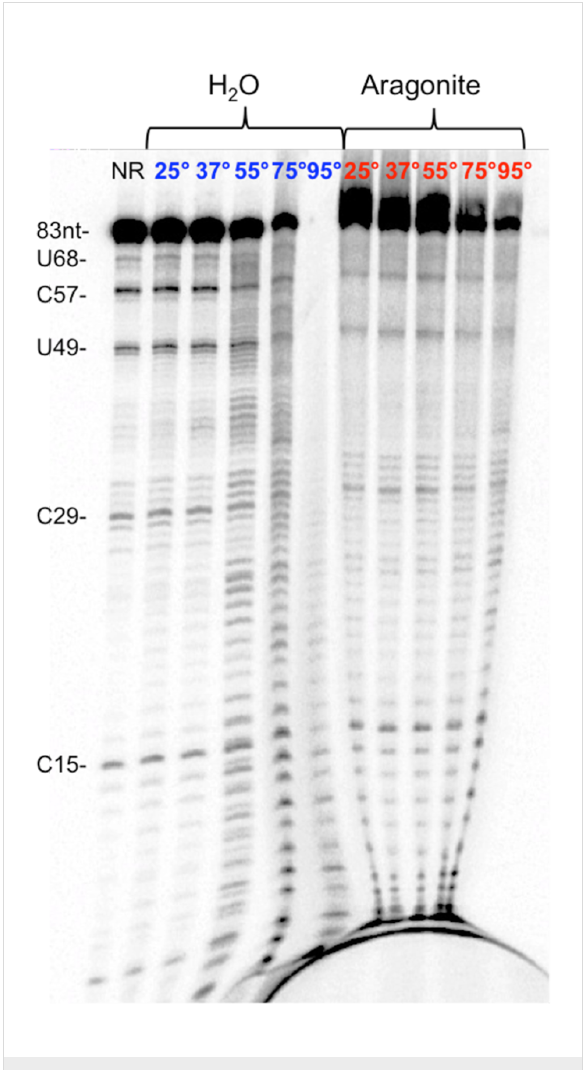
Figure 4: RNA adsorbed on aragonite is resistant to thermal degrada- tion in aqueous solution. 18% denaturing PAGE of a 83-mer ssRNA in- cubated for 2 hours at 25, 37, 55, 75, and 95 °C, either free (left) or adsorbed to aragonite (right). Full length RNA and nucleotides in the sequence that are hot spots for degradation are indicated on the